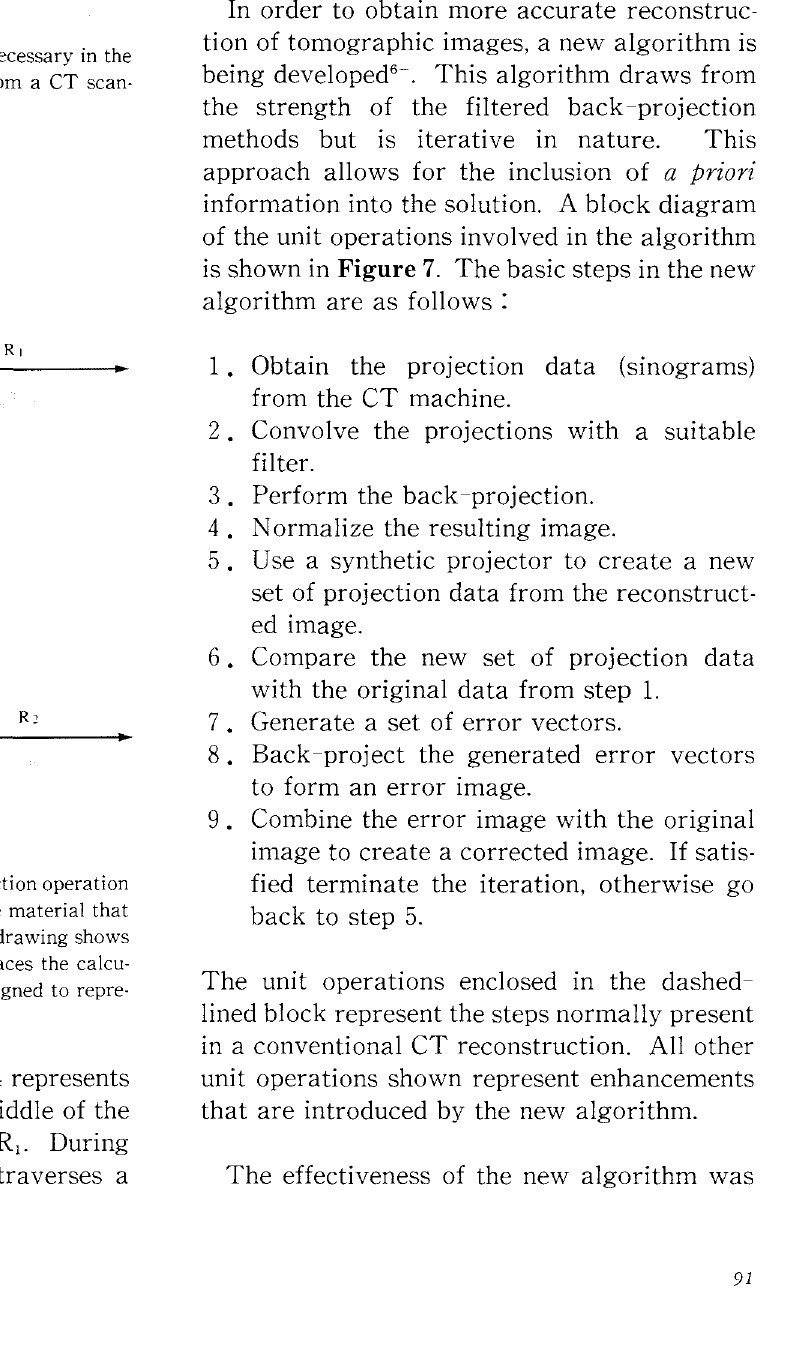
Fig. 5 A block diagram showing the steps necessary in the construction of an image obtained from a CT scan ner.